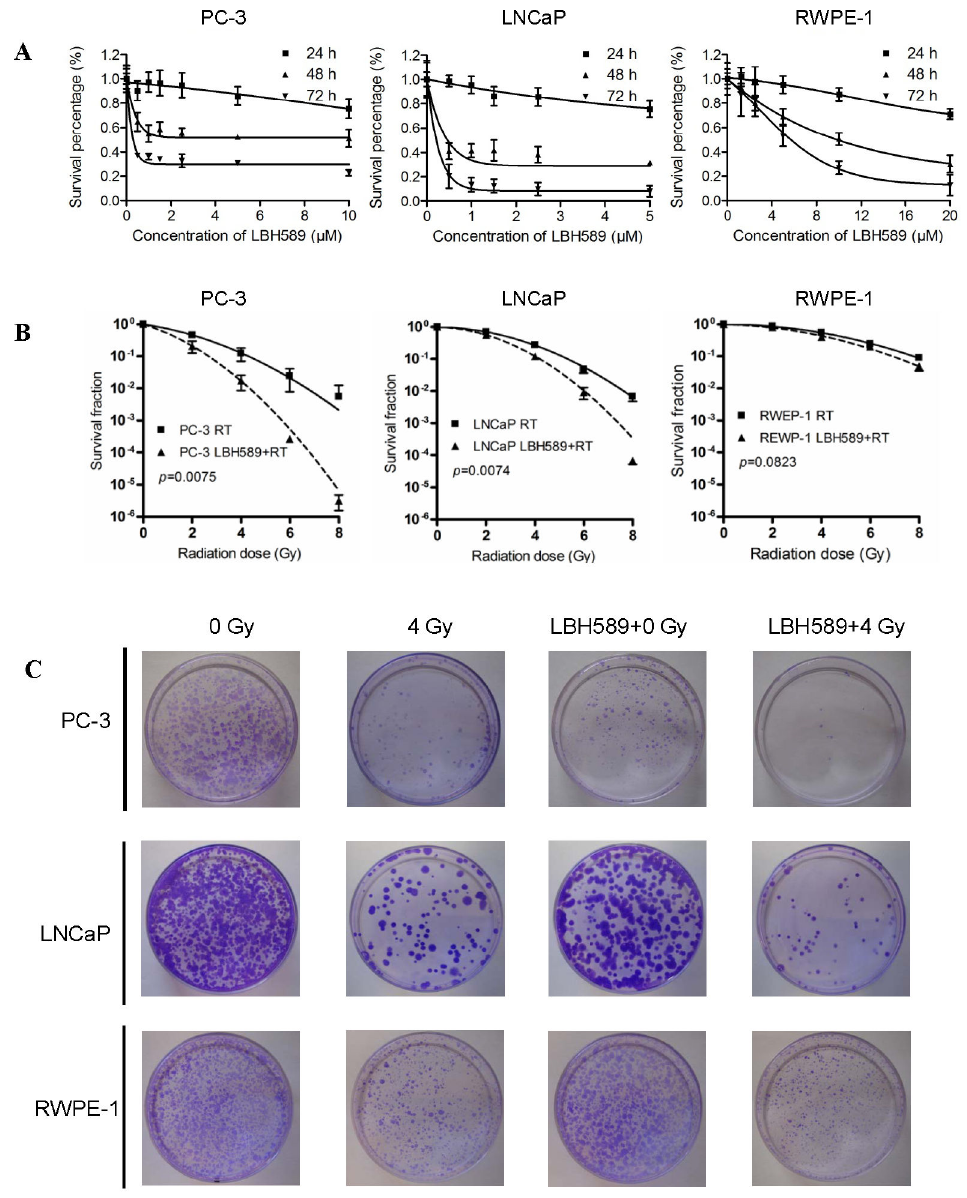
Figure 1. Effect of LBH589 on cell growth and effect of RT or combination treatment (LBH589 and RT) on colony forming in CaP cell lines and normal epithelial prostate cell line. ( A ) Cells were treated with a range of concentrations of LBH589 for 24, 48 and 72 h; ( B ) Cells were treated with RT or combination with RT and LBH589 for analysis of colony-forming efficiency. Survival fractions were significantly reduced in PC-3 and LNCaP CaP cells ( p <0.01), but not in normal REWP-1 cells ( p >0.05); ( C ) Typical images are shown for colony growth in RT and combination treatment (LBH589 and RT) in CaP and normal prostate cells. All results were from three independent experiments (N=3). Points, mean; bars,